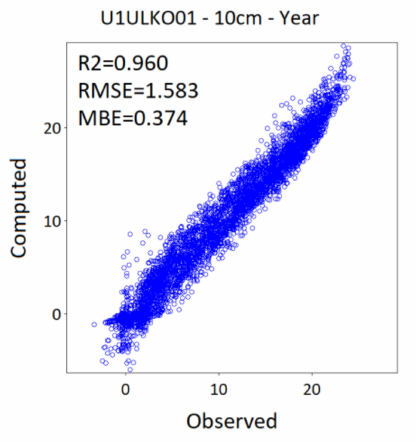
Figure A15. Validation at site U1ULKO01 for 10 cm soil depth.